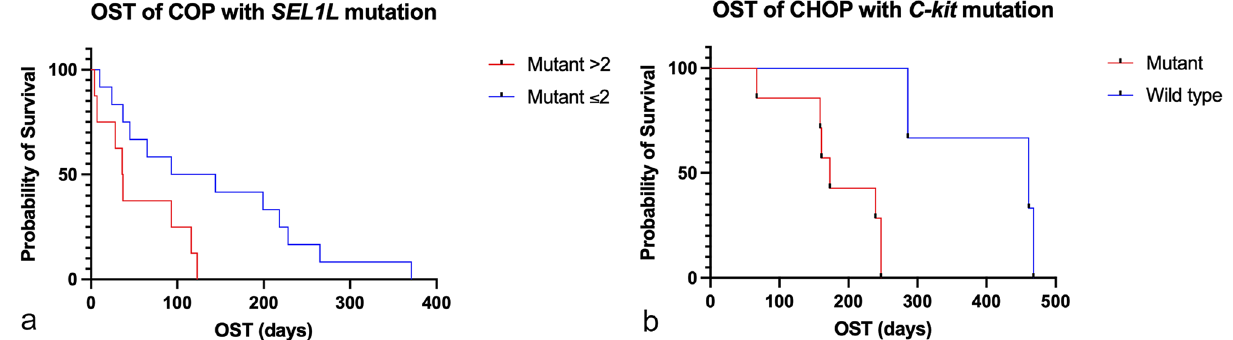
Figure 3. Kaplan–Meier survival analysis of overall survival time (OST) in DLBCL dogs treated with COP and CHOP protocols. ( a ) The median OST of COP-treated dogs with 3–5 variants on SEL1L was 37 days comparing to dogs with ≤ 2 variants on SEL1L (119 days, p = 0.03). ( b ) CHOP-treated dogs with mutant c-Kit had lower median OST than wild-type c-Kit . (173 and 461 days, respectively; p =